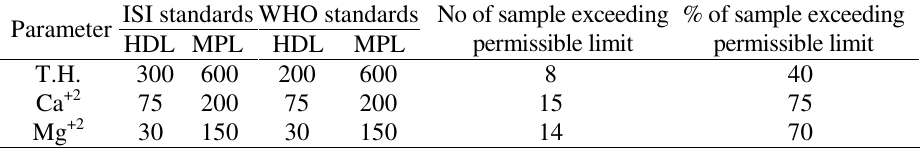
Table 1 . Comparison of TH content in the groundwater of the study area with drinking water